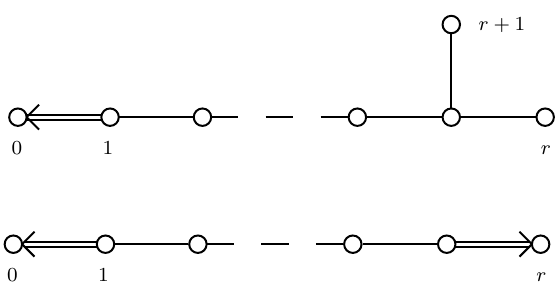
Figure 2 . Dynkin diagrams of B (1) Carroll